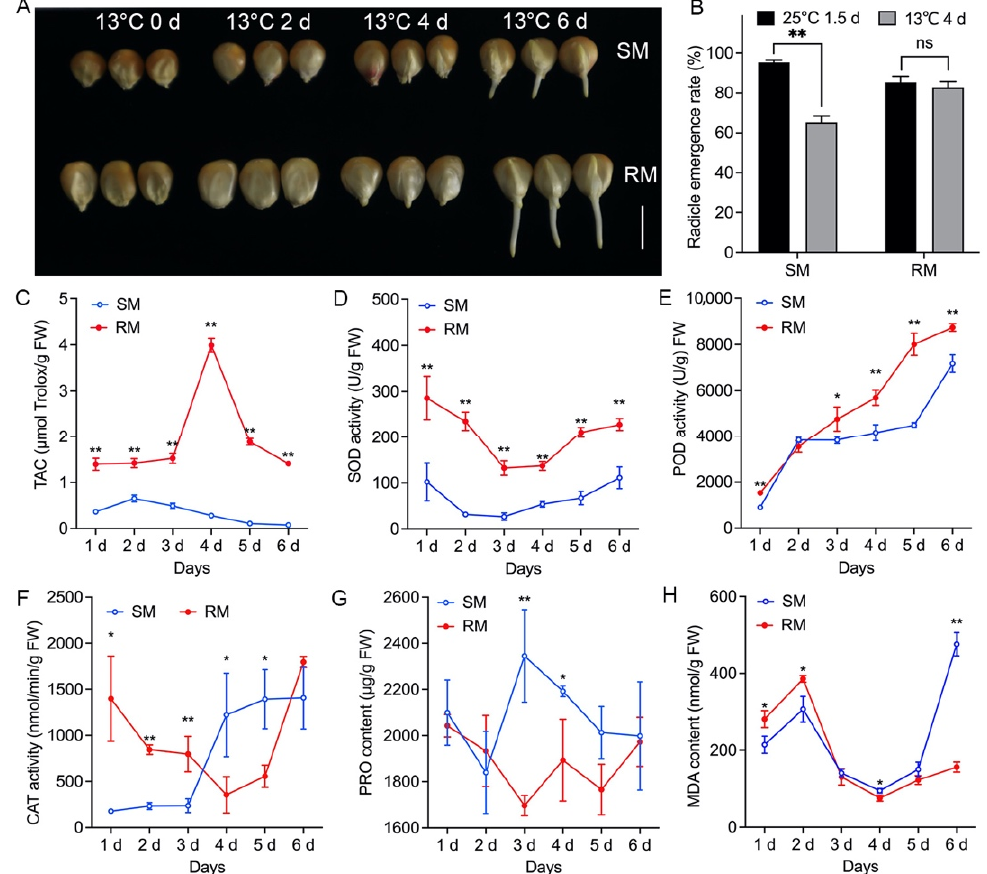
Figure 1. Germination characteristics, antioxidant activities, PRO content, and MDA content in two maize inbred lines under low-temperature stress. ( A ) Phenotypes of seed germination, ( B ) Percentage of radicle protrusion, ( C ) TAC, ( D ) SOD activity, ( E ) POD activity, ( F ) CAT activity, ( G ) PRO content, ( H ) MDA content in two maize inbred lines at 13 °C germinated from 1 to 6 d. Data are means ± standard deviation ( n = 3 replications of 30 plants). Asterisks denote a significant difference according to an unpaired Student’s t -test (*: p < 0.05; **: p < 0.01; ns, not significant.